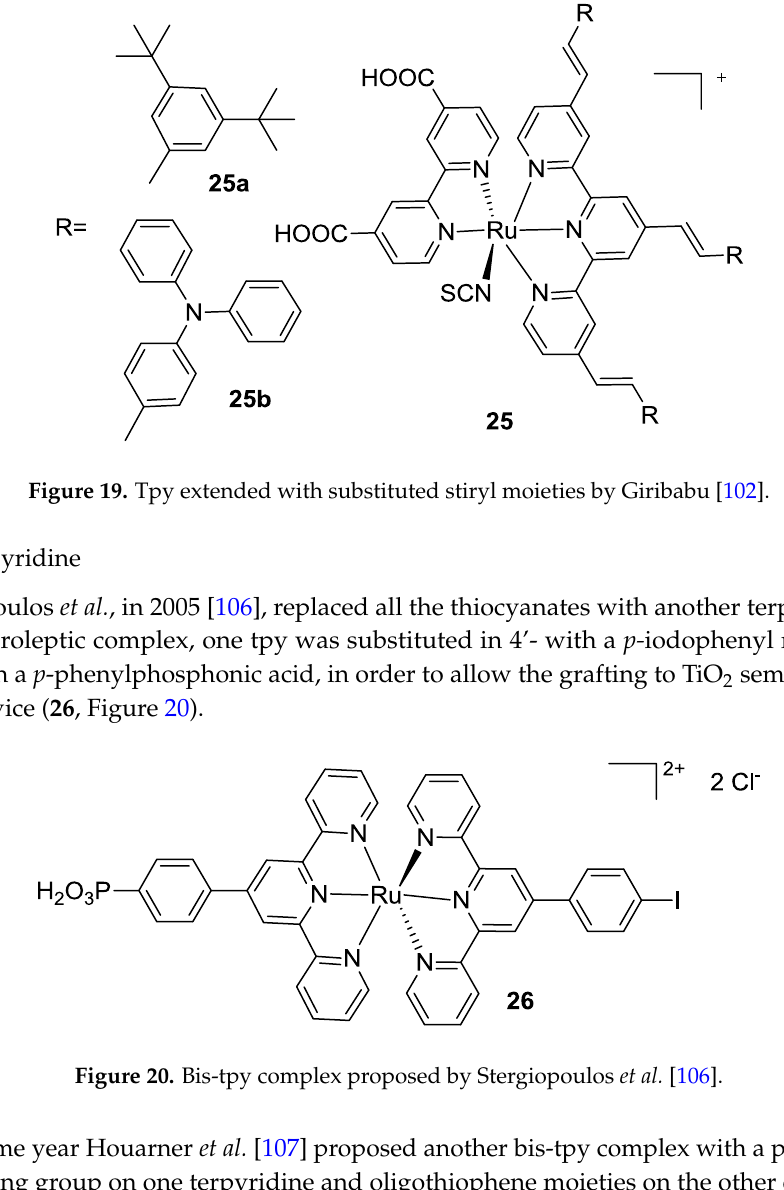
Figure 21. A first series of bis-tpy complexes proposed by Houarner et al. [107].